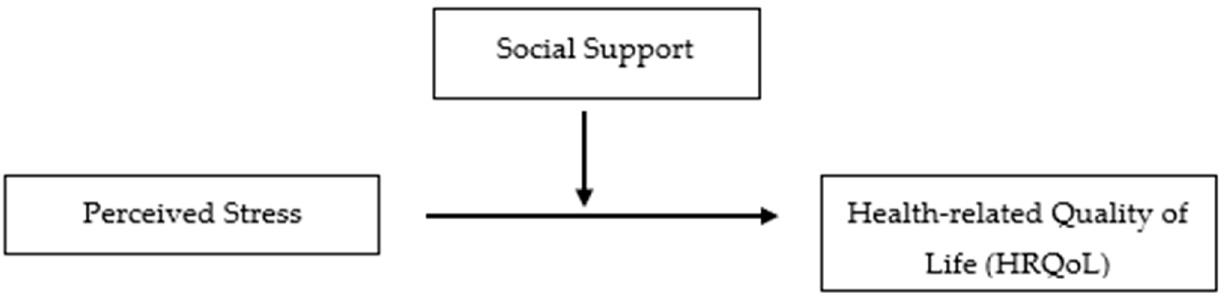
Figure 1. Moderation model of social support’s relation to perceived stress and health-related quality of life. The stress buffering model provides a conceptual framework for identifying a moderator of the association between stress and health-related quality of life. The independent variable is perceived stress. The dependent variable is HRQoL, measured by self-rated health, the number of poor physical and mental days, and activity limited due to poor physical/mental days. Social support is the hypothesized moderator that lies between stress and HRQoL. The stress buffering model would suggest that social support would buffer a presumed negative association between stress and HRQoL.